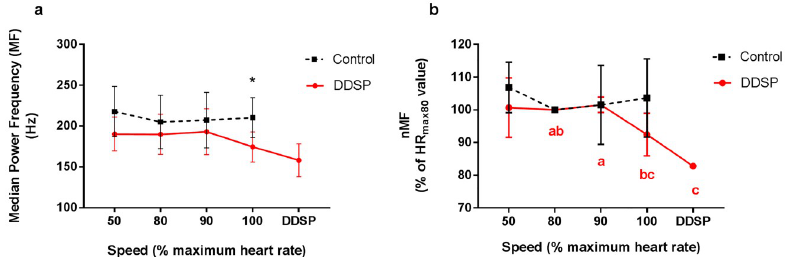
Fig 4. Median Power Frequency (MF) of the thyro-hyoid muscle electrical activity decreases at highest exercise intensity in horses affected by palatal instability and intermittent dorsal displacement of the soft palate (DDSP). 4a) The DDSP group horses show a significantly lower MF at HR max100 compared to normal horses. 4b) A significant drop in MF normalized to the frequency recorded at HR max80 (nMF) was recorded before developing palatal displacement in 2 horses. Data are mean and SD. � p < 0.05. Different letters indicate statistically significant difference between nMF recorded at different speed intervals in the DDSP horses.